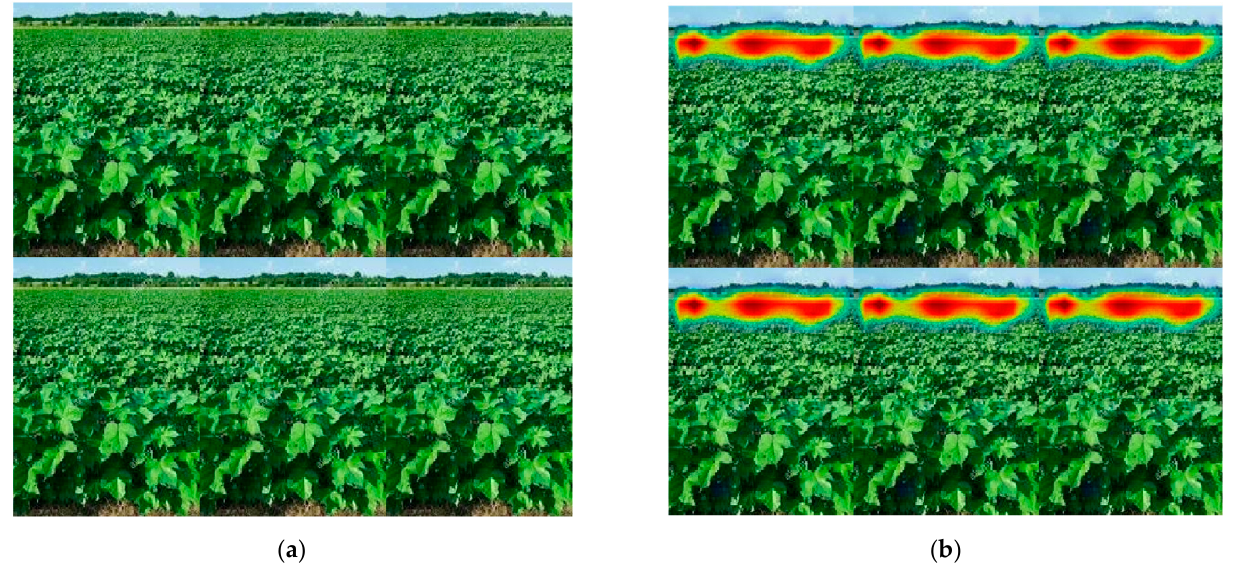
Figure 8. False-positive classification results. ( a ) Input image. ( b ) Heatmap.